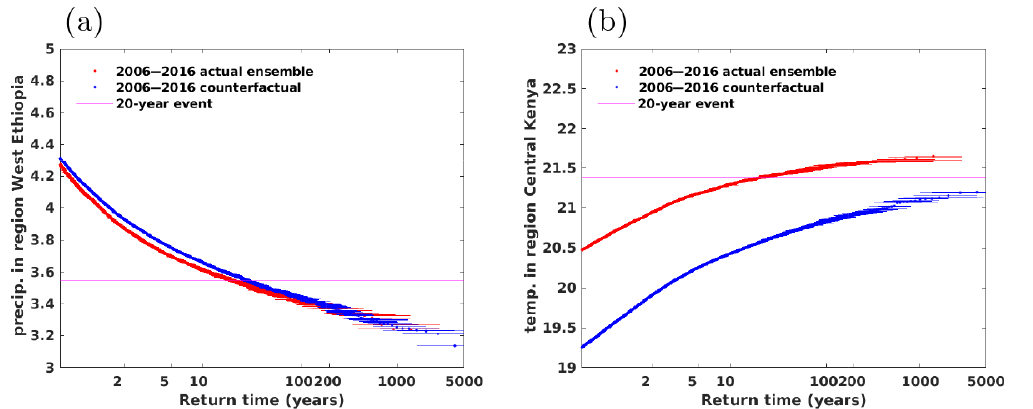
Figure 4. Illustrative examples of the weather@home time slice model runs. (a) Annual mean precipitation [mm/d] in region WE. (b) Annual mean temperature [ ◦ C] in region CK. The red markers are for the present-day climate and the blue markers are for the climate in pre-industrial times. The magenta line illustrates the magnitude of a hypothetical event with a 20-year return period in the present-day